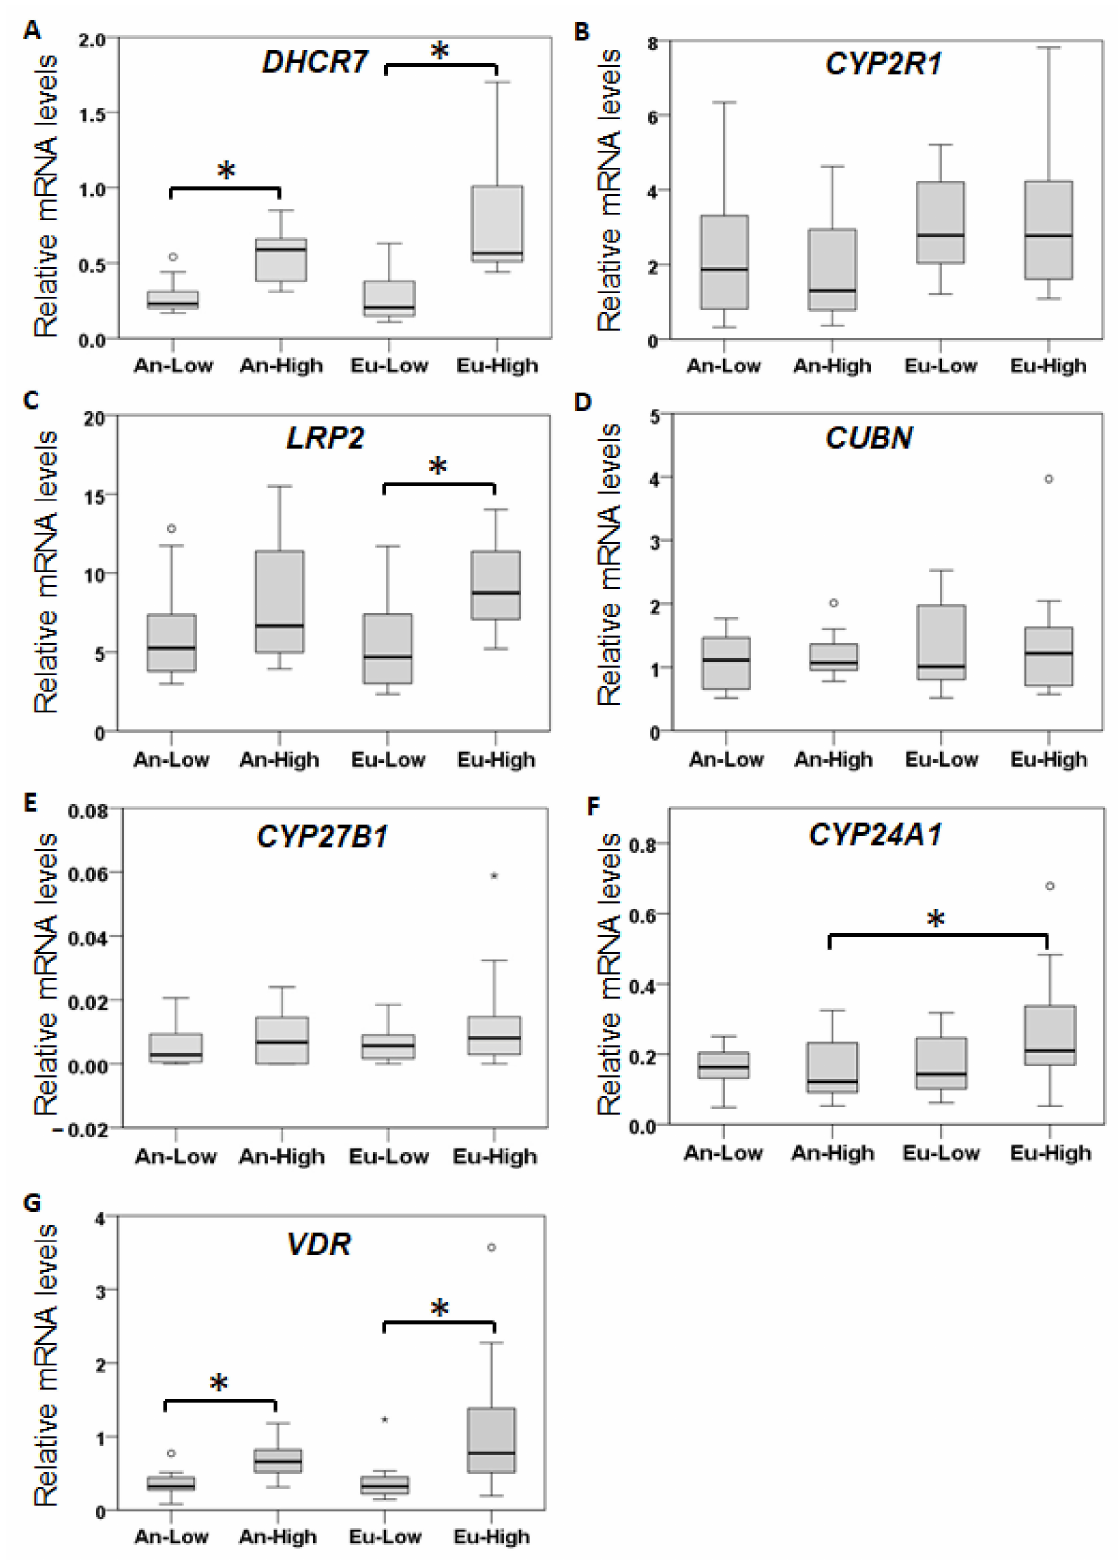
Figure 2. Placental expression of vitamin D-related genes. Placental mRNA levels, shown relative to ACTB mRNA levels ( × 10 − 3 ), were determined by Taqman probe qPCR as described under methods. Data is shown in boxplots for DHCR7 ( A ), CYP2R1 ( B ) LRP2 ( C ), CUBN ( D ), CYP27B1 ( E ), CYP24A1 ( F ), and VDR ( G ). * p < 0.05 as determined by one-way ANOVA followed by LSD post-hoc